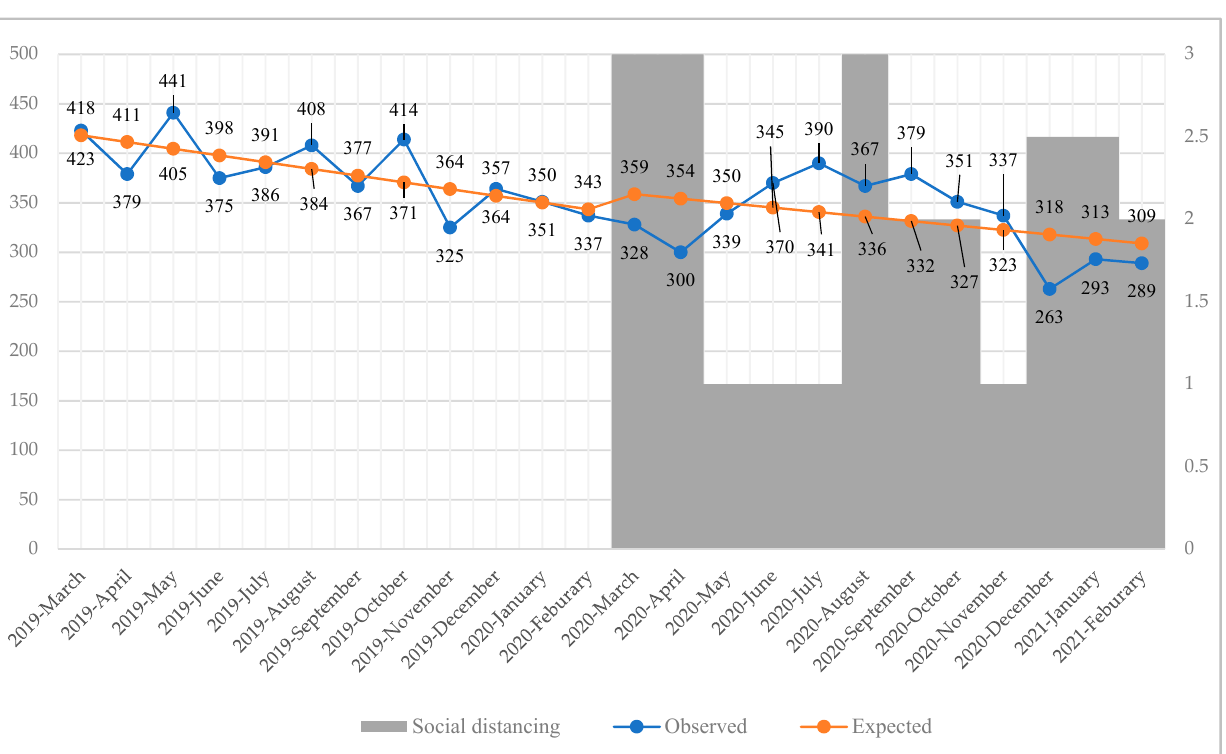
Figure 3. Comparison of the observed monthly trends in patients experiencing MHCs who used EMSs and the numbers expected by segmented regression analysis. The Y ‐ axis on the left is the number of patients experiencing MHCs who used EMSs. The right Y ‐ axis is the social distancing level (level 3 was the strictest). The blue dotted line is the observed number of patients. The orange dotted line was derived by segmented regression analysis. The breakpoint was March 2020. MHC, mental health crisis; EMS, emergency medical service. Table 1. Parameter estimates, standard errors, and p values from the segmented regression models predicting the mean monthly number of patients experiencing MHCs who used EMSs.